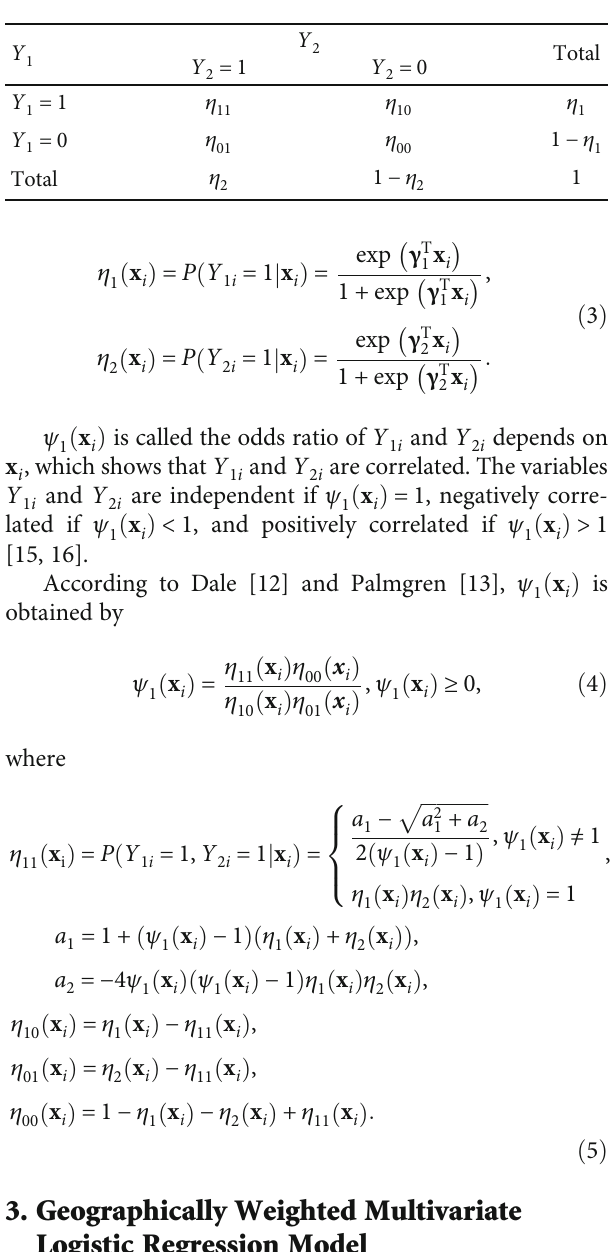
Table 1: Probabilities for the dependent variables of the MLR